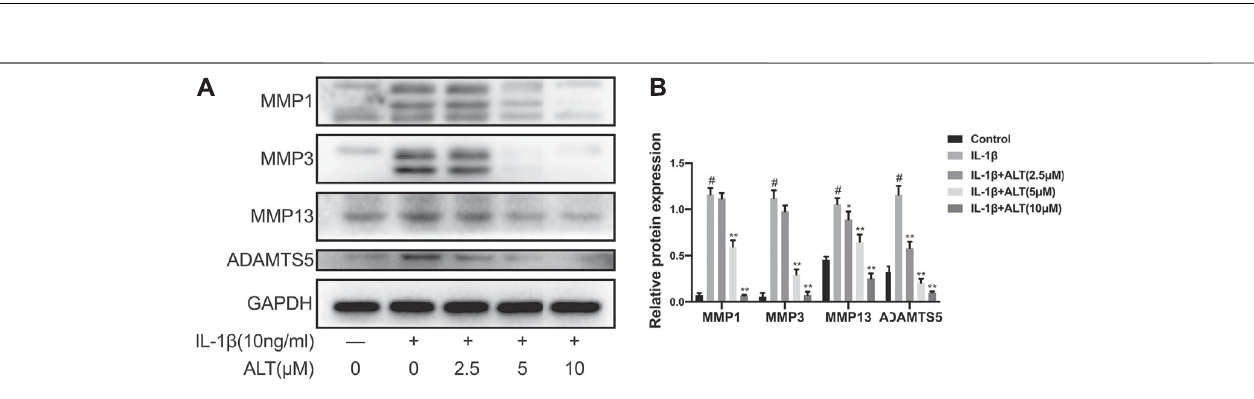
FIGURE 2 | ALT moderated IL-1 β -induced iNOS and COX2 expression in mouse chondrocytes. Cells were stimulated by IL-1 β (10 ng/ml) in the presence or absence of ALT (2.5, 5, and 10 μ M) for 24 h. (A) Expression of iNOS and COX2 were detected by Western blot. (B) Relative protein expression was quali fi ed by ImageJ software, GAPDH was served as the loading control ( n (cid:2) 3). # p < 0.05 vs. control group; * p < 0.05 vs. IL-1 β group; ** p < 0.01 vs. IL-1 β group.